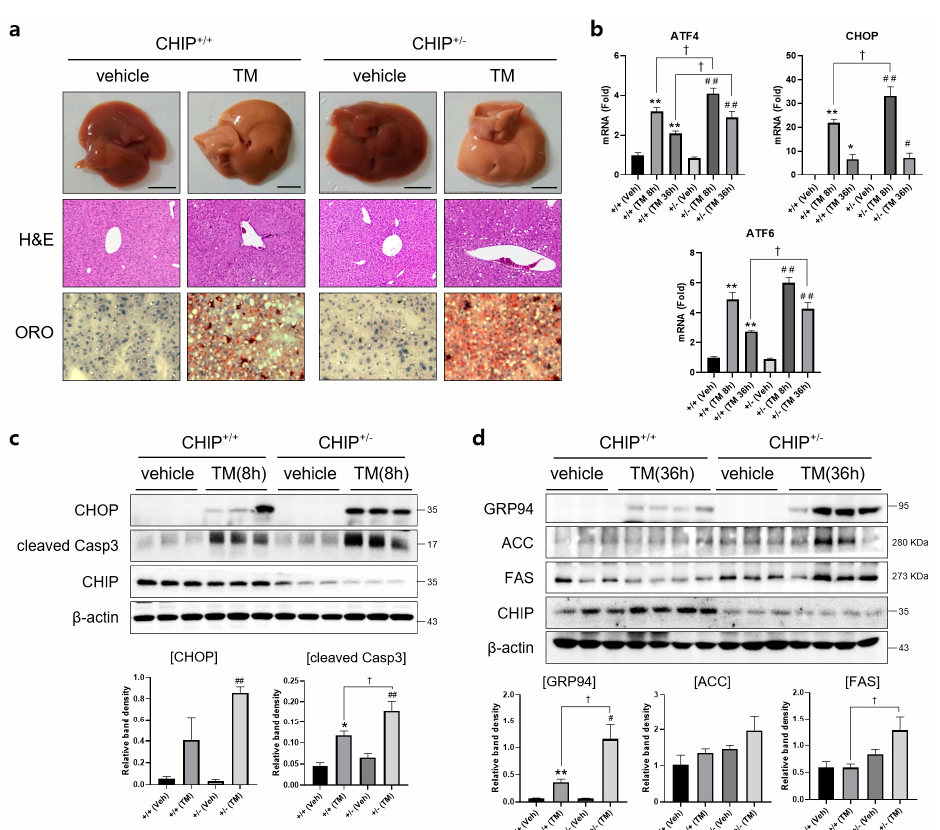
Figure 2. CHIP is responsible for tunicamycin-induced hepatic steatosis via UPR and apoptosis in mice. CHIP +/+ and CHIP +/ − mice were injected intraperitoneally with tunicamycin (TM, 2 μ g/g body weight) and sacrificed 8 h or 36 h (n = 5) after TM injection. ( a ) Representative picture of whole mouse livers (top). Liver tissue sections were stained with H&E (middle) and Oil Red O (bottom) (original magnification, ×200). ( b ) Expression levels of UPR-related genes in livers of the CHIP +/+ and CHIP +/ − mice were measured by qRT-PCR. Relative expression levels were normalized to GAPDH levels. * p < 0.05 and ** p < 0.01 vs. CHIP +/+ mice (vehicle), # p < 0.05 and ## p < 0.01 vs. CHIP +/ −